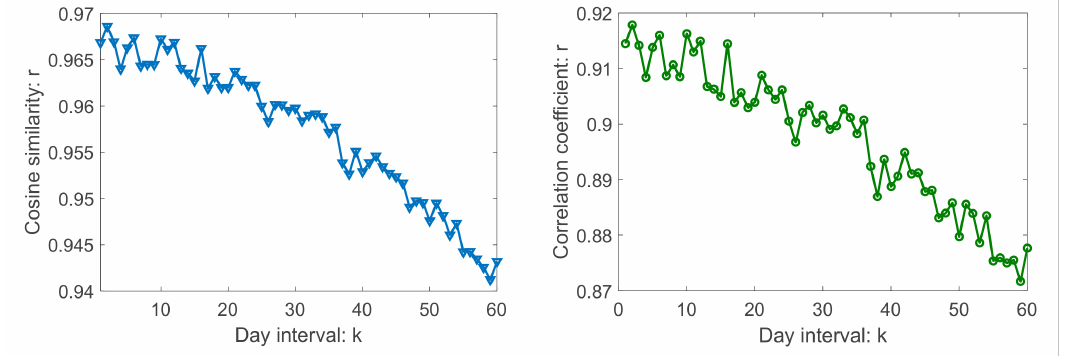
Figure 3. The similarity degree in adjacent days for k -day